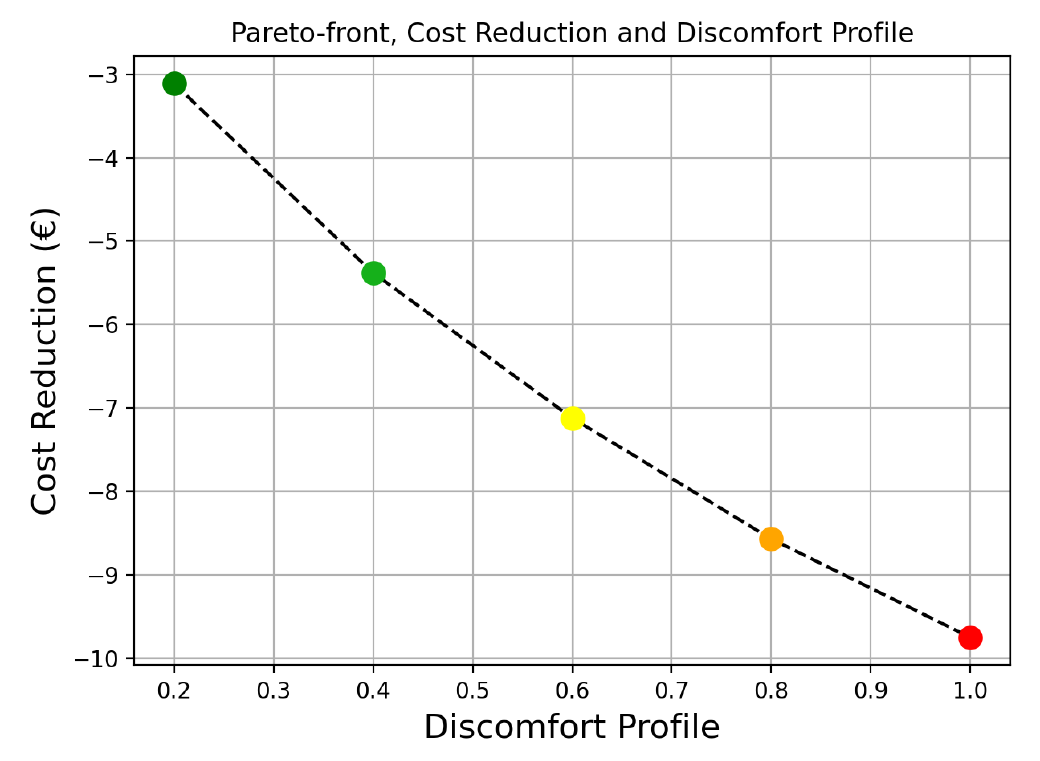
Figure 6. Pareto front of optimal